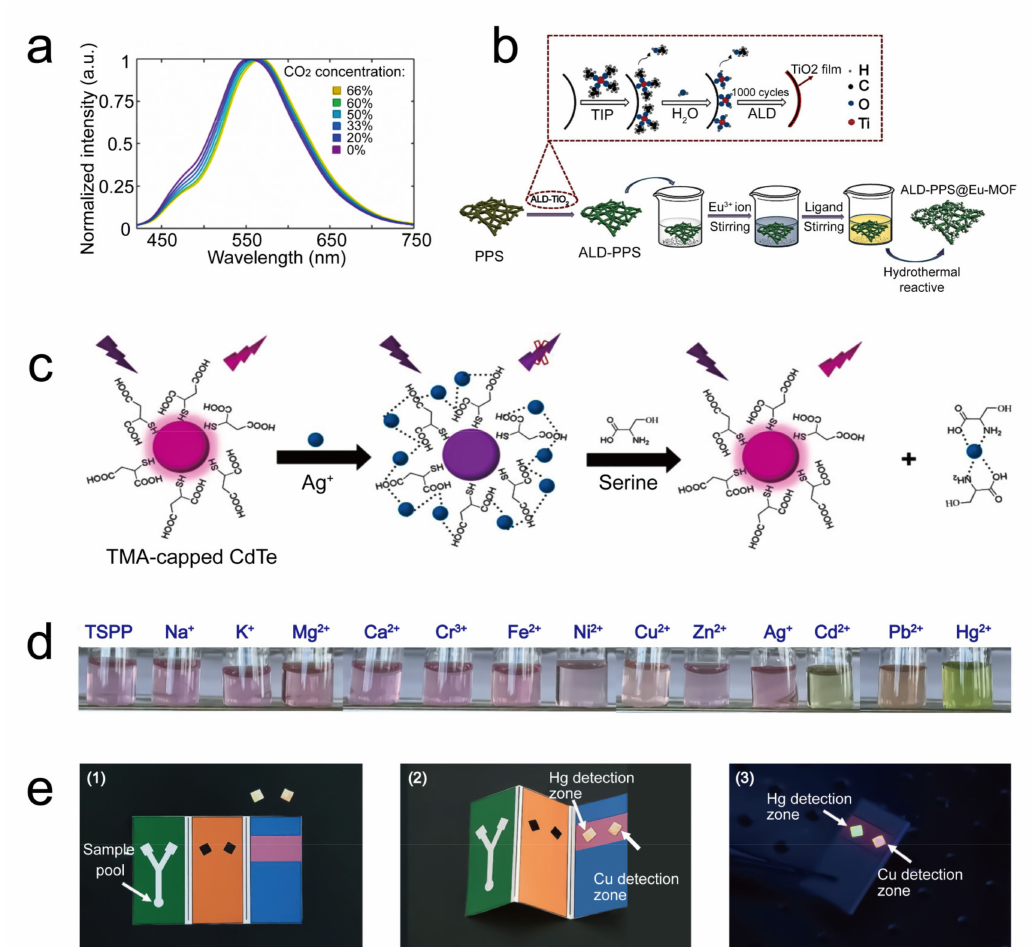
Figure 5. Paper-based sensors for an environmental quality inspection. ( a ) Photograph images presented the color of the phenolic biosensor with varied catechol concentrations. 1 represented the control paper, and 2 represented the working paper. Reprinted/Adapted with permission from Ref. [34]. Copyright 2020 Springer-Verlag GmbH Germany, part of Springer Nature. ( b ) Schematical representation for the synthesis of the Fe 3+ -sensitive paper-based sensor. Reprinted/Adapted with permission from Ref. [83]. Copyright 2021 Elsevier B.V. ( c ) Ag + quenched and serine restored the fluorescence of thiomalic acid-modified CdTe (TMA-capped CdTe). Reprinted/Adapted with permission from Ref. [35] Copyright 2020 Elsevier B.V. ( d ) The color-developing material were used for Cu 2+ and Hg 2+ measurements. Reprinted/Adapted